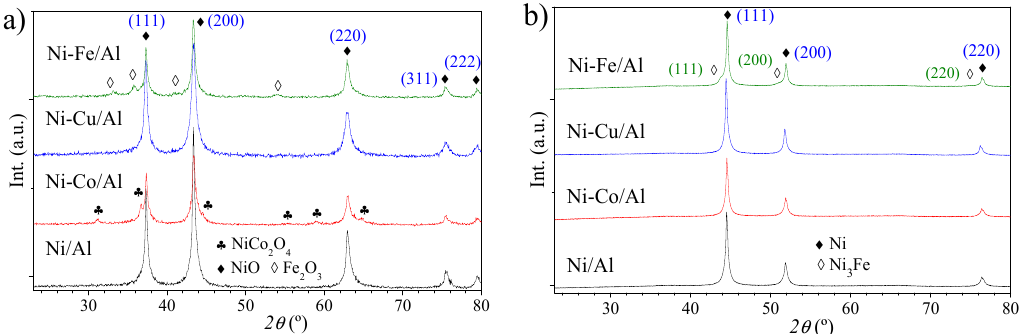
Figure 2. Diffractograms of ( a ) fresh; and ( b ) reduced catalysts at 650 °C.